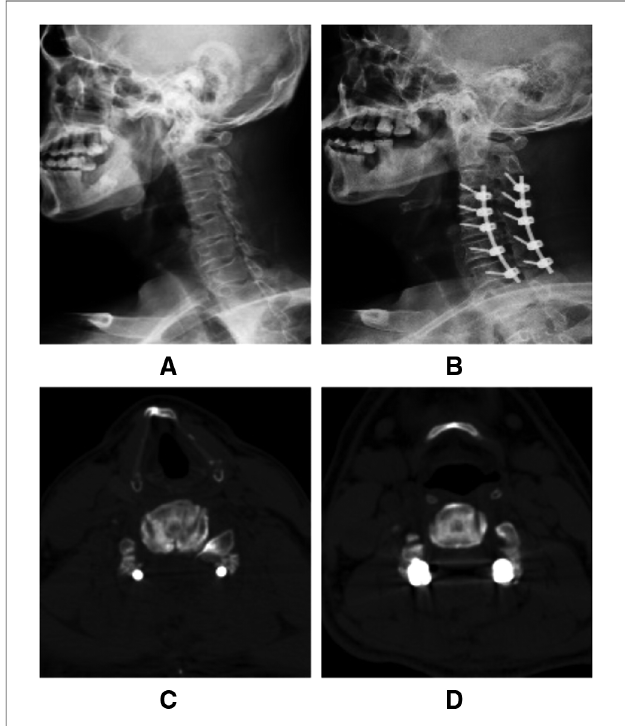
foraminotomy at the Lt. C4/5 and Rt. C4/5 and C5/6 levels. ( A,B ) Cervical curvature correction and foramen expanding at Rt. C4/5 and C5/6 levels. ( C,D ) Postoperative bilateral C4/5 and Lt. C5/6